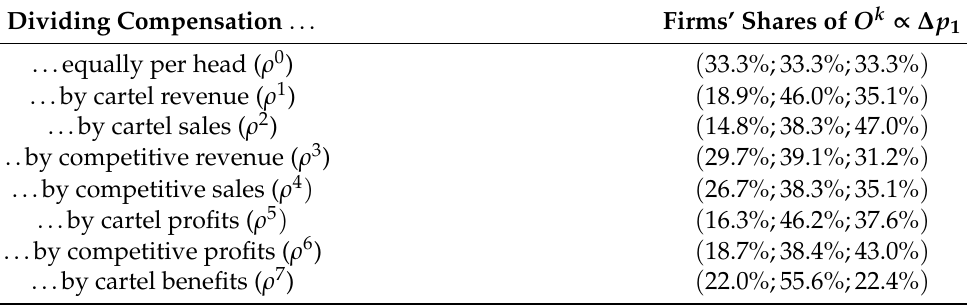
Table 1. Proportioning heuristics discussed by legal practitioners. Dividing Compensation